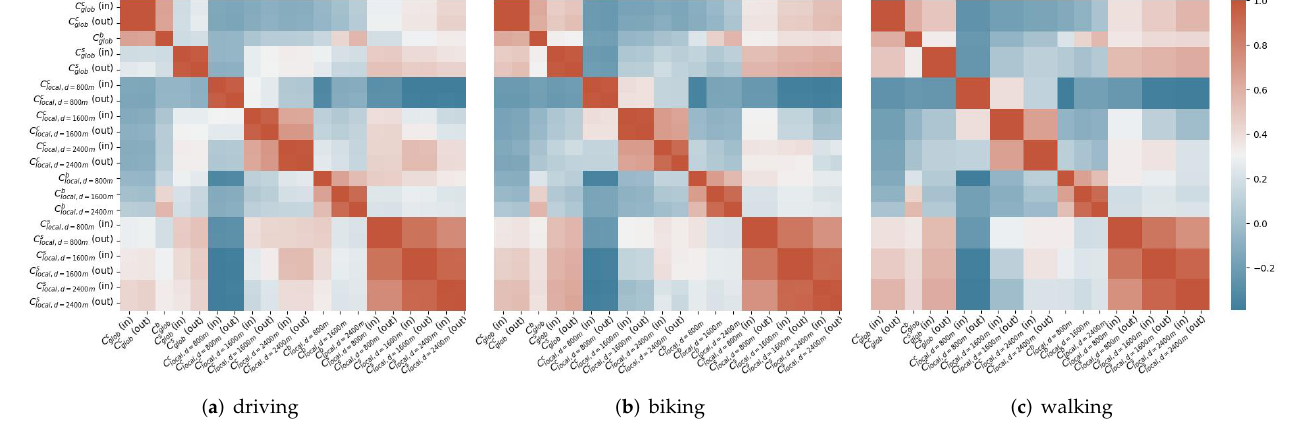
Figure 6. Pittsburgh: Pair-wise correlation between different centrality measures when considering the road network a directed graph. The color bar on the right side shows the range of correlation coefficients with the highest as 1 and the lowest as − 0.4 per our data.